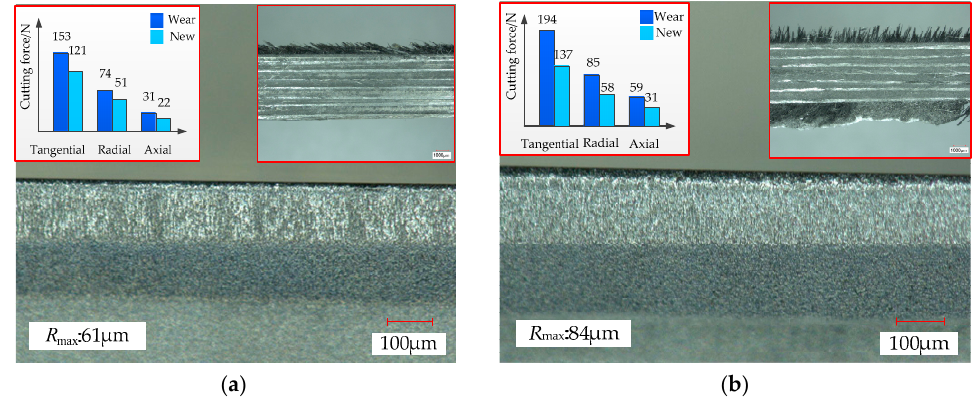
Figure 10. Comparison of the wear morphologies between the two PCD cutters: ( a ) staggered PCD cutter; ( b ) straight-teeth PCD cutter.